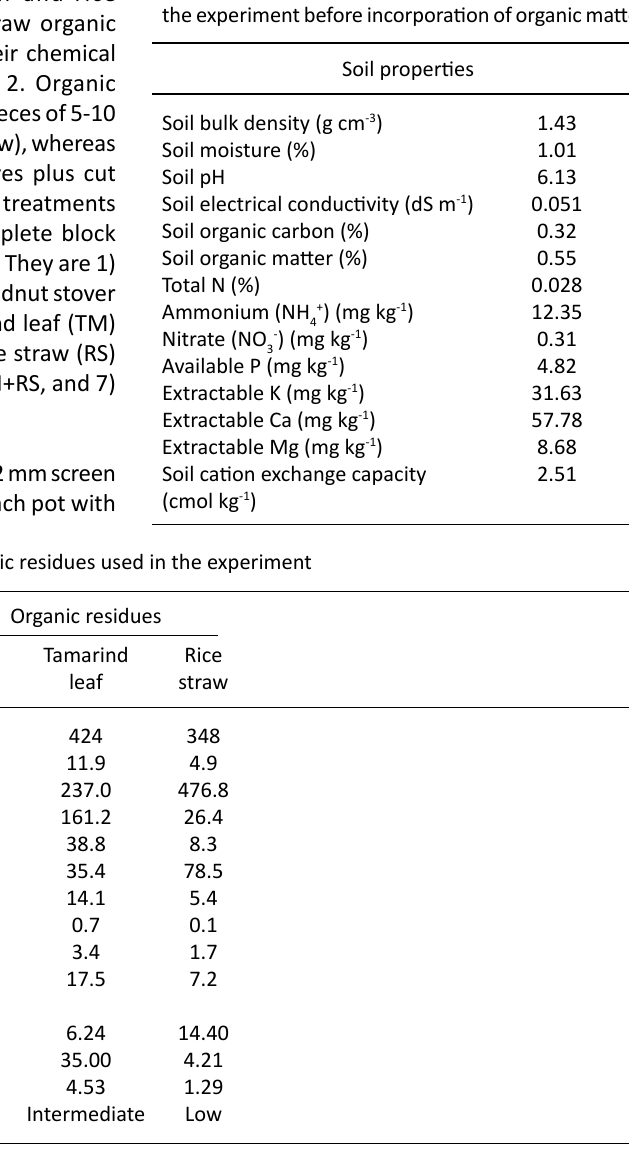
table 1. Soil physical and chemical properties used in the experiment before incorporation of organic matter